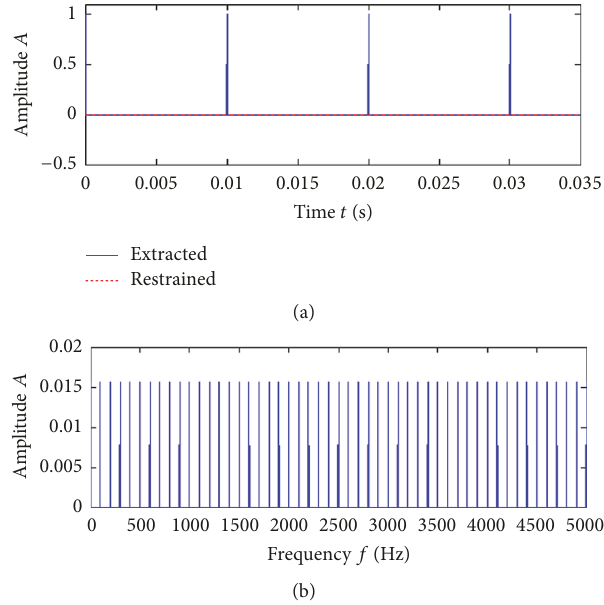
Figure 3: Periodic impacts extraction result of CTH: (a) time domain waveform and (b) FFT